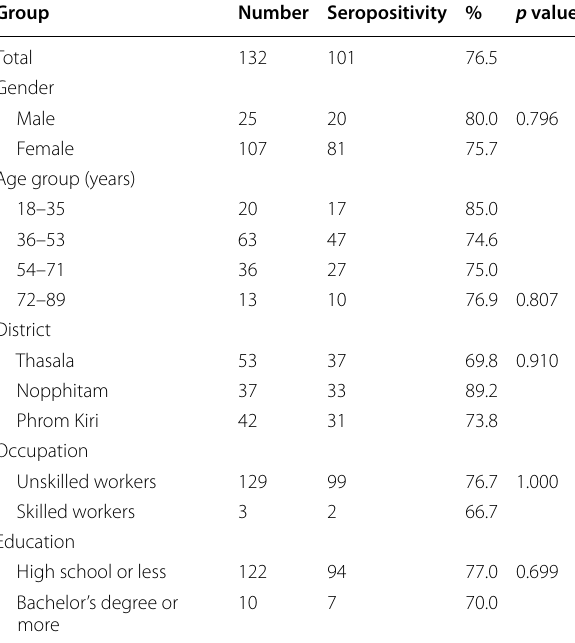
Table 2 Seroprevalence of Toxocara canis infection among